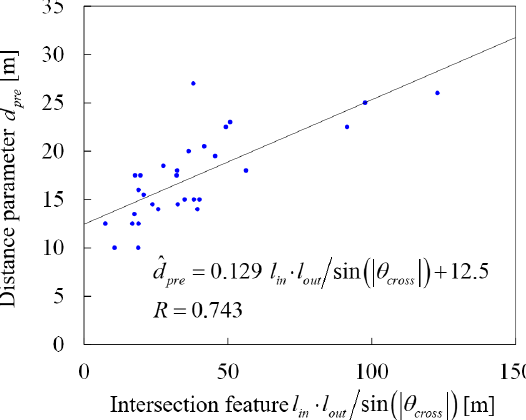
Figure 10. Parameter estimation for the Triclothoidal curve. There was a slightly strong linear correlation between the intersection parameters and the distance parameter d pre